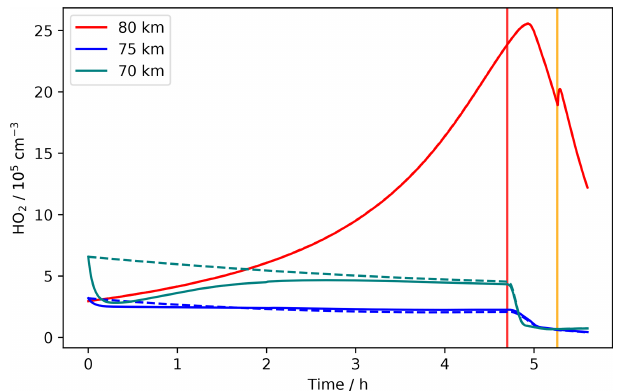
Figure 10. Concentrations of HO 2 at altitudes 70, 75, and 80km for RUN1. The solid lines depict the sprite model simulation, and the dashed lines depict the no-sprite simulation (at 80km the lines lie on top of each other). The vertical orange line indicates the time of sunrise, and the vertical red line indicates the time when the model starts to account for scattered sunlight (at a solar zenith angle of 98 ◦